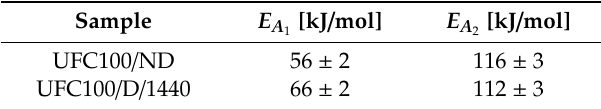
Table 4. Tabularized values of the activation energy that was assigned to the decomposition steps and was calculated with the use of Broido’s method [57]; E A1 —activation energy of water evaporation process; E A2 —activation energy of cellulose thermal degradation.